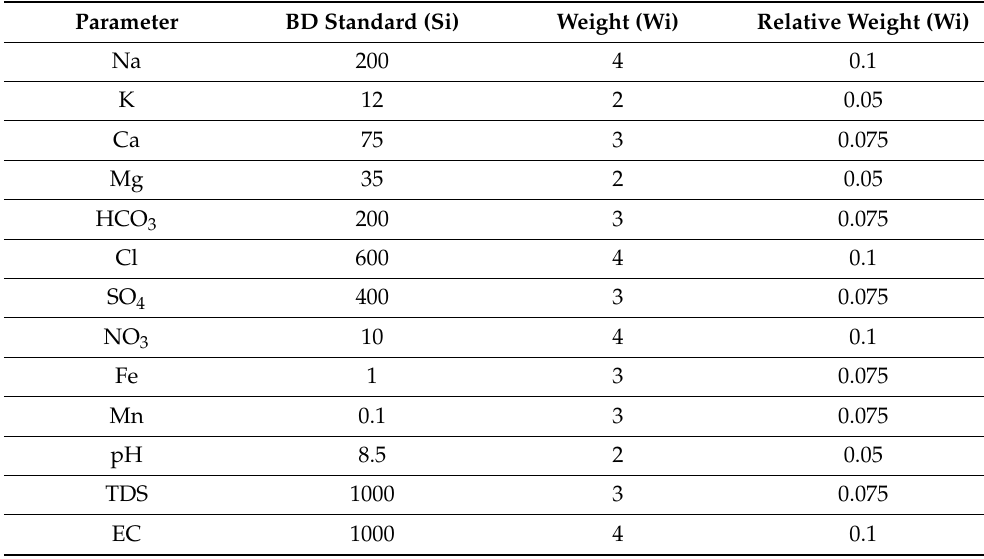
Table A1. Weight and relative weight of the physiochemical parameters. EC is in µ s/cm, the rest in